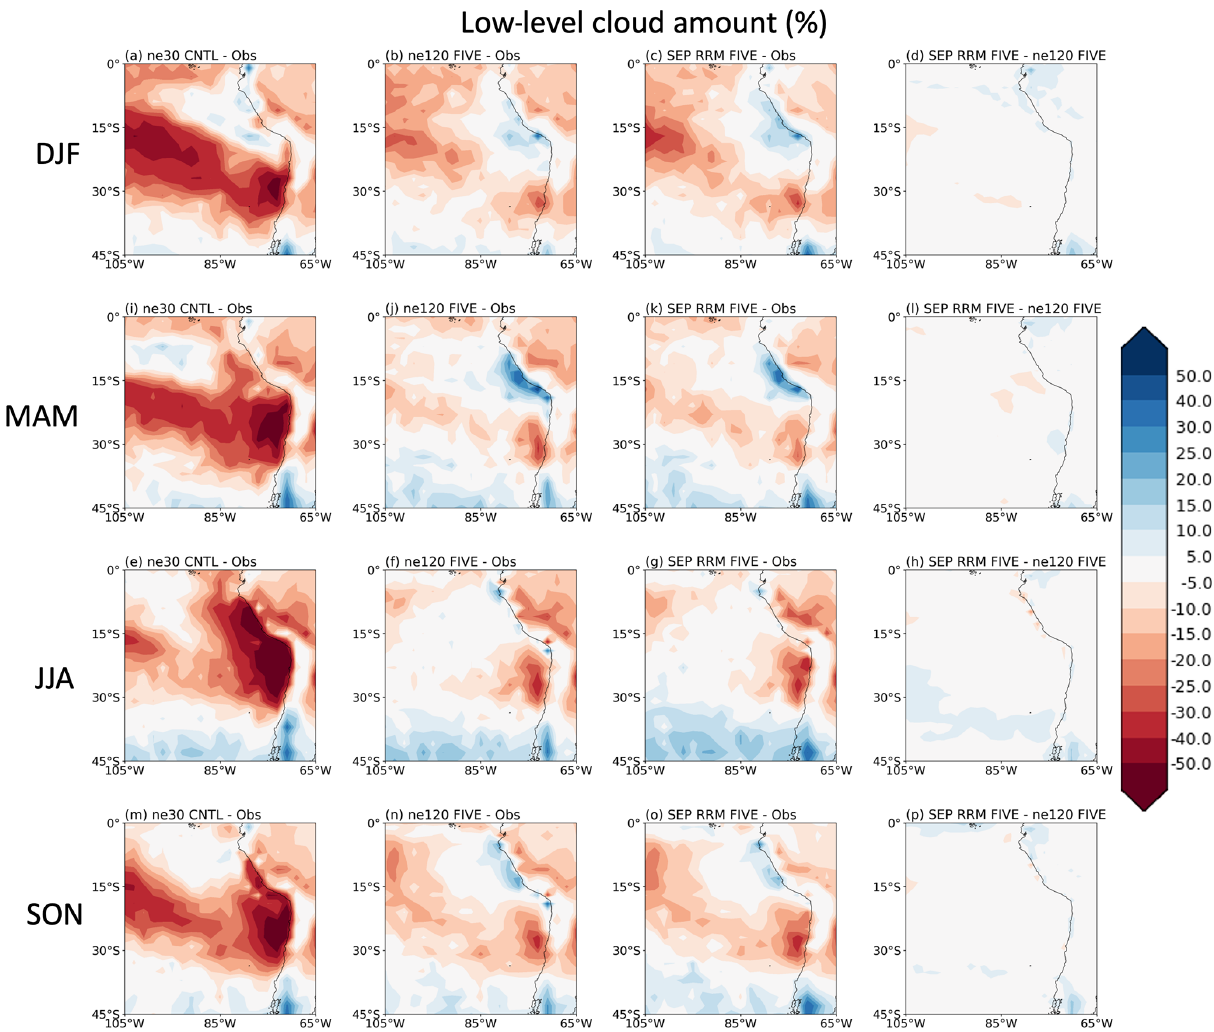
Figure 12. Differences in low-level cloud amount computed relative to CALIPSO observations for ne30-CNTL (a, i, e, m) , ne120-FIVE (b, j, f, n) , and SEP-RRM-FIVE (c, k, g, o) . Also displayed are the differences in SEP-RRM-FIVE computed relative to ne120-FIVE (d, l, h, p) . Results are displayed for the DJF (a–d) , MAM (i–l) , JJA (e–h) , and SON (m–p) seasons.